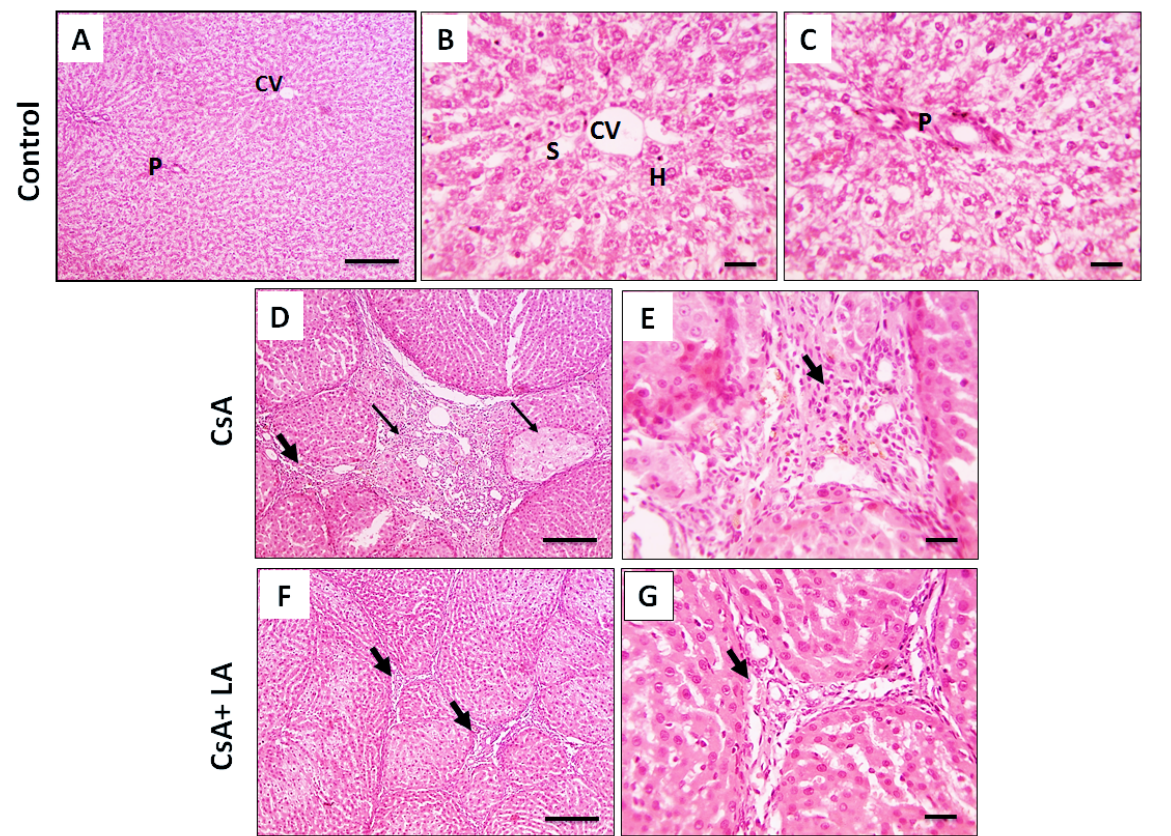
Figure 1. Microscopic pictures of H&E-stained hepatic sections. The control normal group ( A – C ) shows regular arrangement of hepatic cords (H) around central veins (CV) with normal portal areas (P) and sinusoids (S). Hepatic sections ( D , E ) from the Cyclosporine A (CsA)-treated group show cirrhotic nodules (thin arrows) completely separated by thick fibrous connective tissue (thick arrows) that contains leukocytes, hemosiderin laden macrophages, dilated lymphatics, and proliferated biliary epithelium. Hepatic sections ( F , G ) from the Cyclosporine A + lipoic acid (CsA + LA)-treated group show milder lesions characterized by thin fibrous connective tissue deposition (thick arrows) and contains fewer leukocytes, ( A , D , F ; Scale bar = 100 μ m), and ( B , C , E , G ; Scale bar = 50 μ m). Table 3. Effect of α -LA administration on serum oxidative stress in CsA-treated animals. Parameter